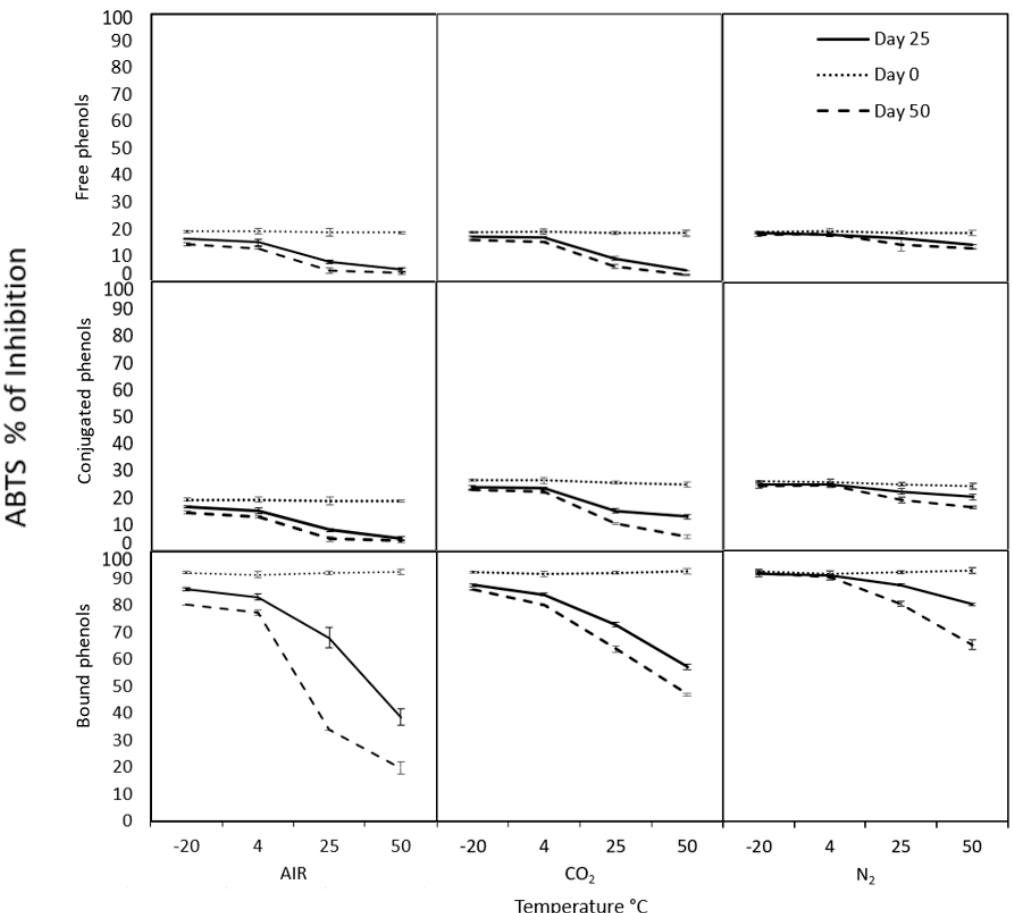
Figure 3. Antioxidant capacity by radical ABTS of free, conjugated, and bound phenols under different storage conditions. Control was air treatment.